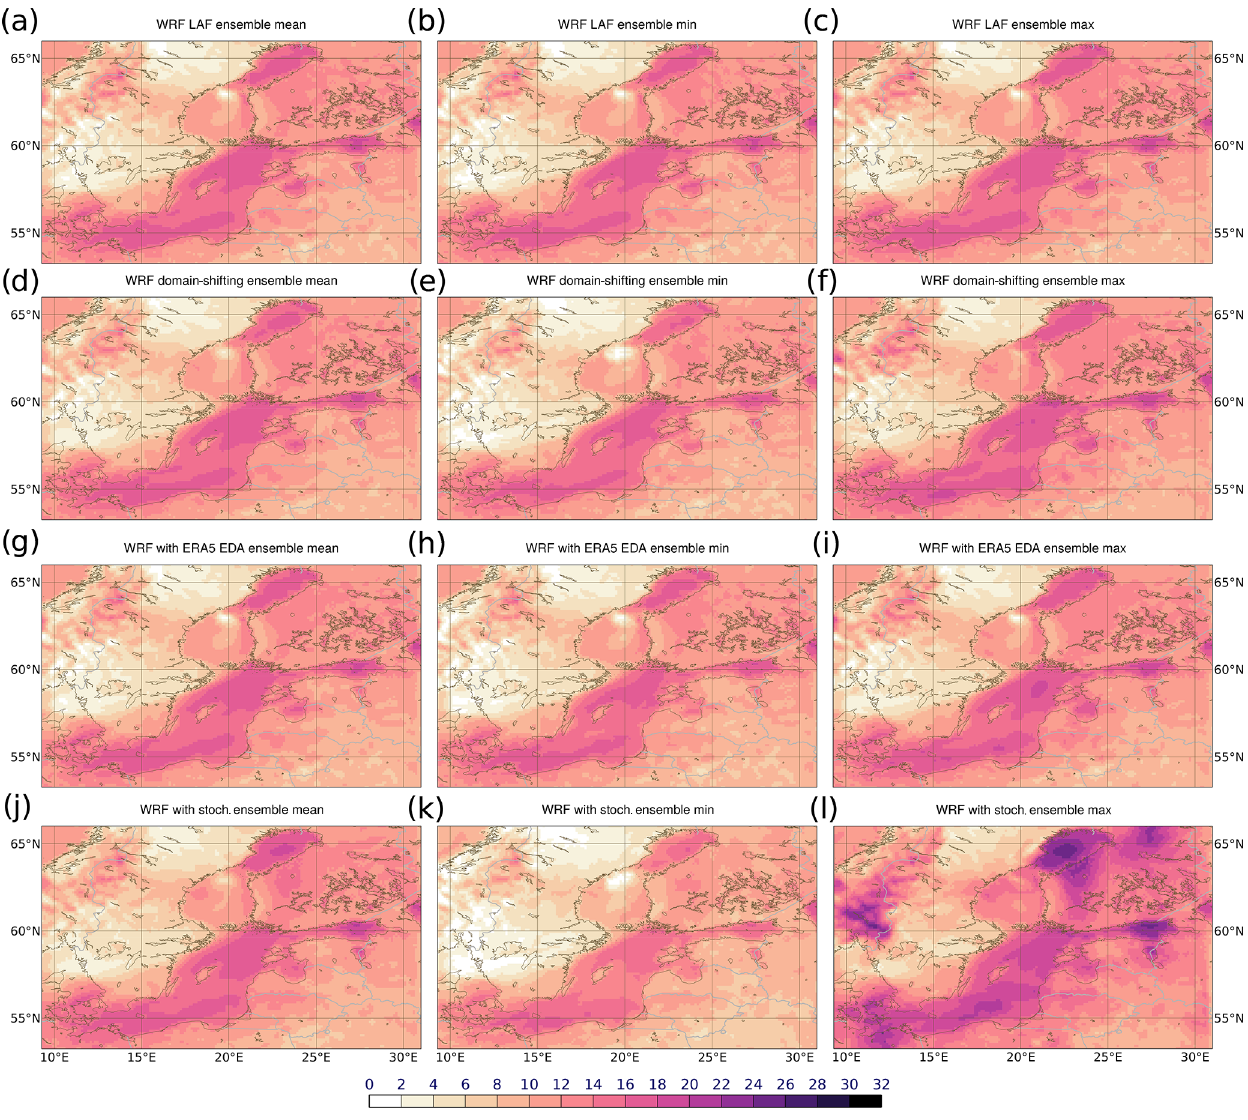
Figure 3. Ensemble mean (a, d, g, j) , minimum (b, e, h, k) and maximum (c, f, i, l) wind speed (ms − 1 ) of WRF ensemble based on LAF approach (a–c) , domain shifting (d–f) , initial conditions from the ERA5 EDA (g–i) and on stochastic perturbations (j–l) . All initialized at 21 February 2002 12:00UTC. Shown are results for 23 February 2002